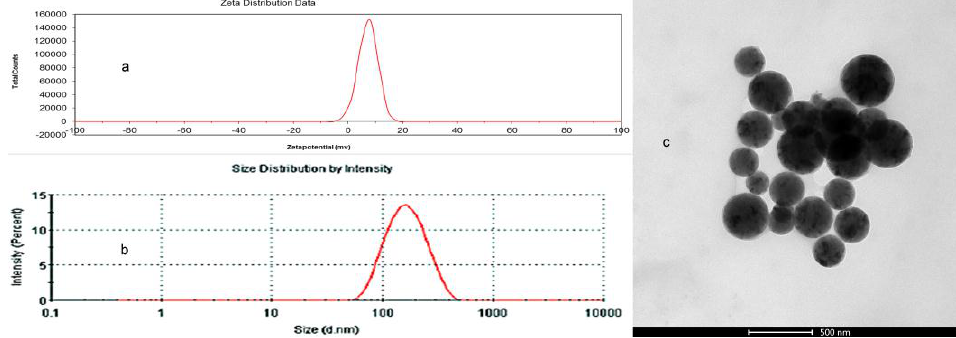
Figure 4. Zeta potential ( a ); size distribution ( b ); and transmission electron microscopy ( c ) of CHAP NPs.